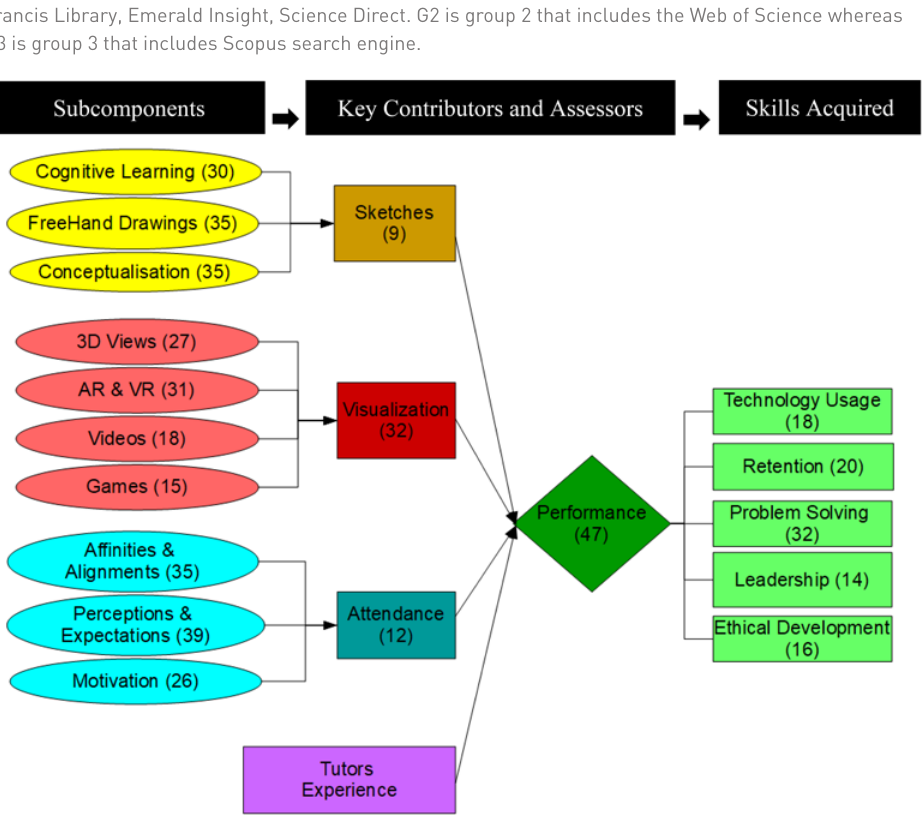
Figure 1 Subcomponents, key contributors, and independent variables of student performance (Note: The numbers in brackets show the percentage contributions of the criteria overall and sub-criteria to the original criteria based on the